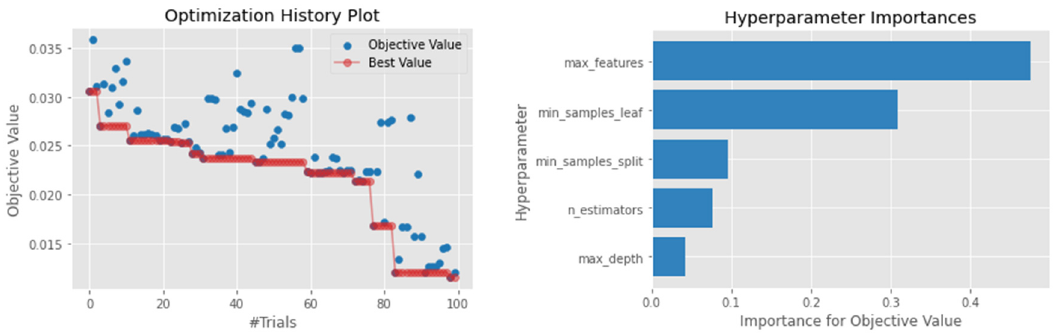
Figure 8. Hyperparameter optimization for the ETS model.